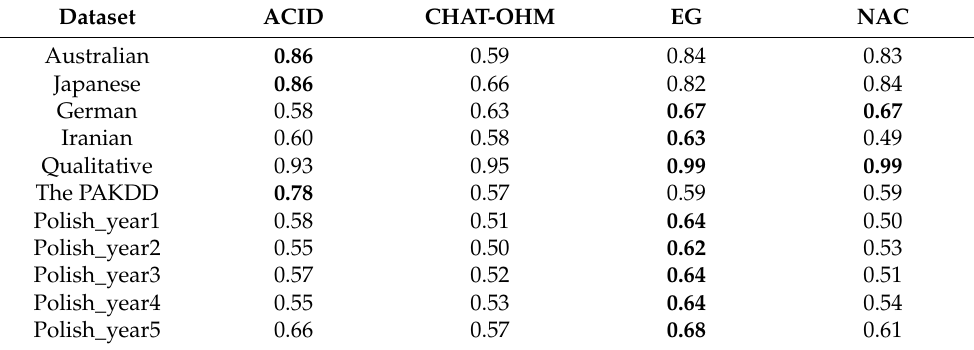
Table 6. F-score of the compared classifiers. The best results are indicated in bold. Dataset